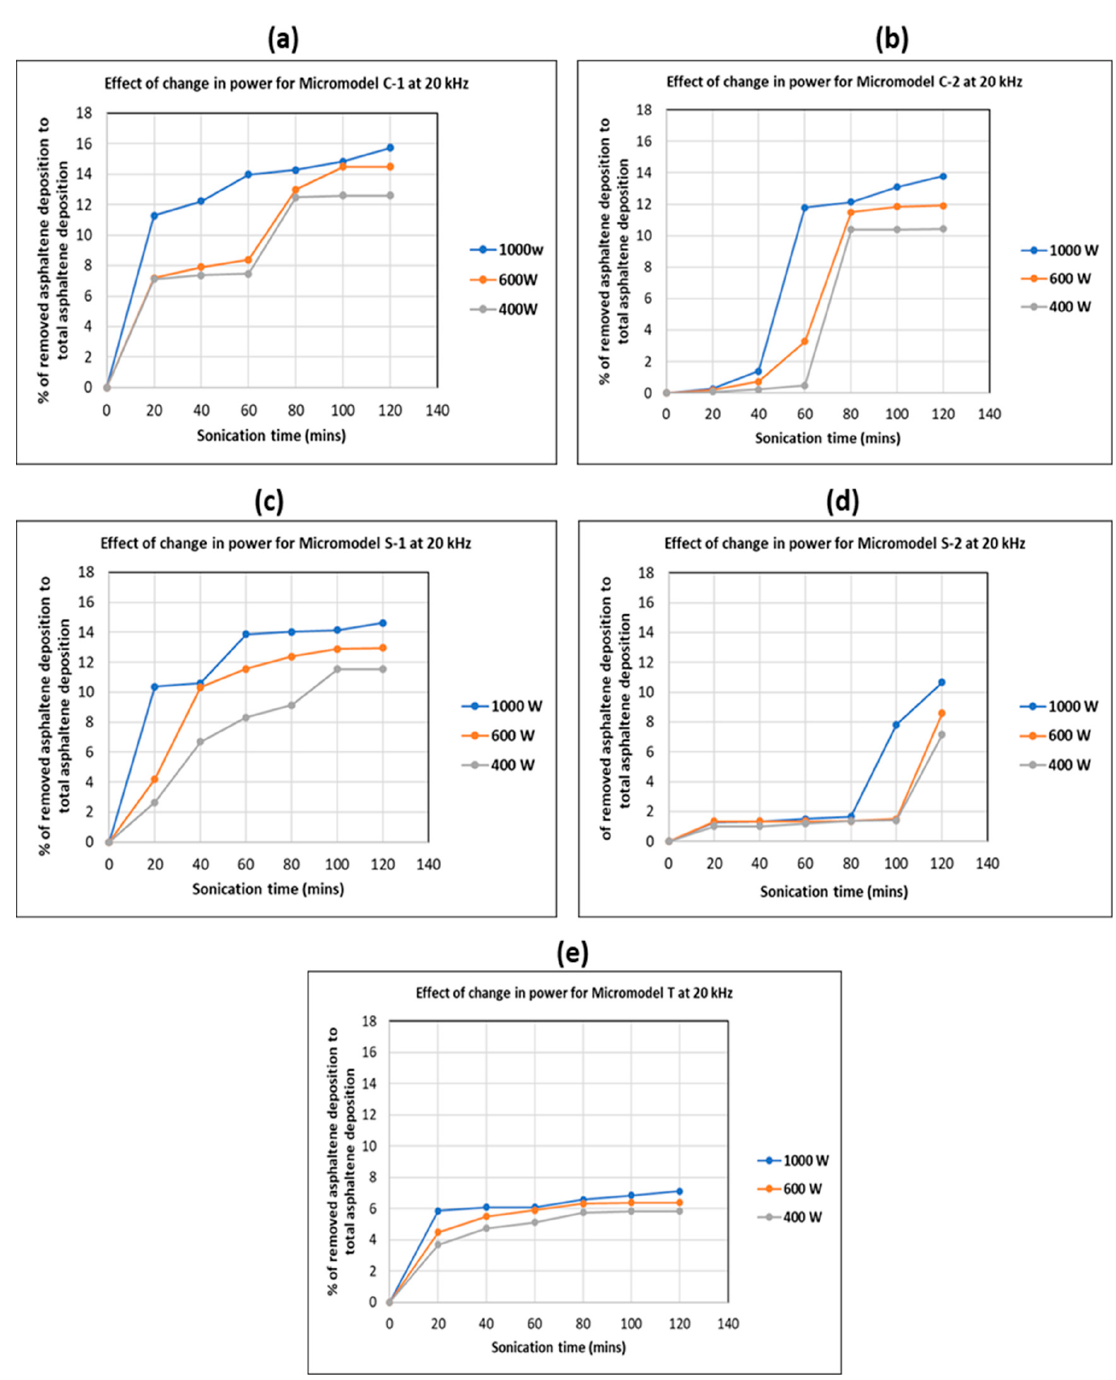
Figure 8. Influence of ultrasonic power variation on the removal of asphaltene deposition under ultrasound in, ( a ) micromodel C-1, ( b ) micromodel C-2, ( c ) micromodel S-1, ( d ) micromodel S-2, and ( e ) micromodel T (reprinted from Otumudia et al., [2] Copyright 2022, LN 5341891002605, with per- mission from Elsevier) .